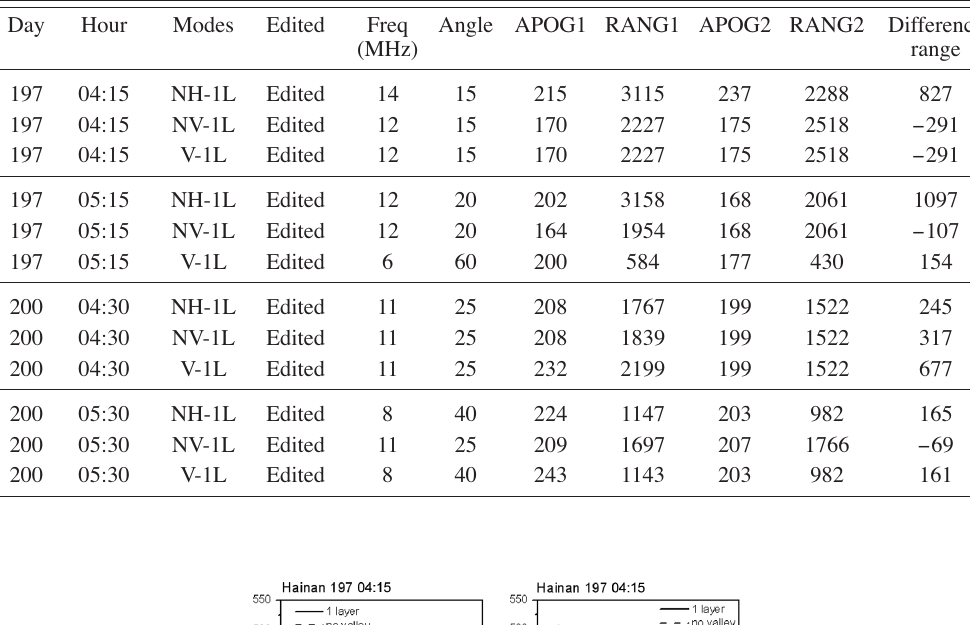
Table III. Maximum range differences for Hainan link. Modes (NH = NHPC , 1L = POLAN 1 -layer , NV = POLAN no valle y, V = POLAN valley ). Manually scaled ionograms are indicated with the word ‘edited’. APOG1 and APOG2 are the apogee heights obtained with first and second option in column Modes and RANG1 and RANG2 their ranges.